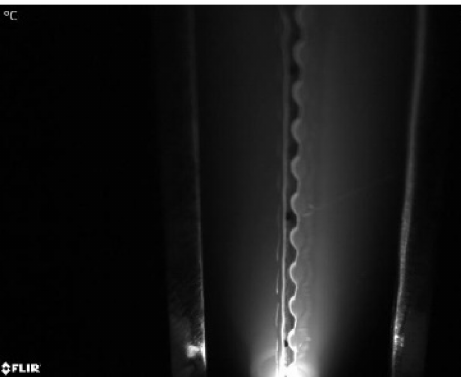
Figure 9. Sample IR image of weld face side from sample S24, where metal plates were not joined because of the too-large offset between them.